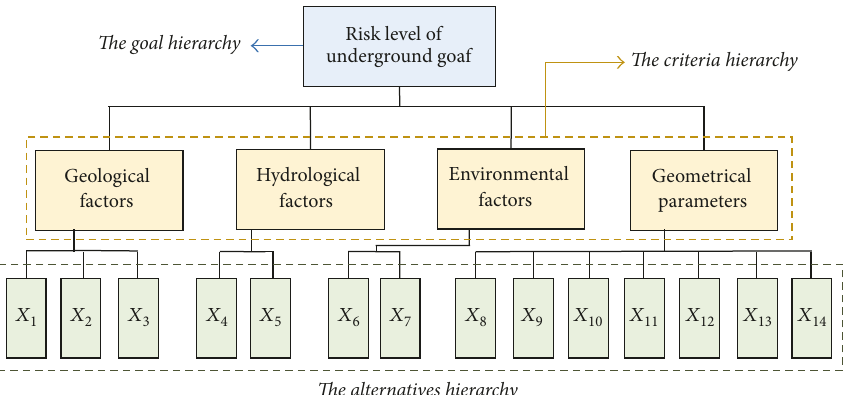
Figure 4: The hierarchical model for AHP, which consists of the goal hierarchy, the criteria hierarchy, and the alternatives hierarchy.